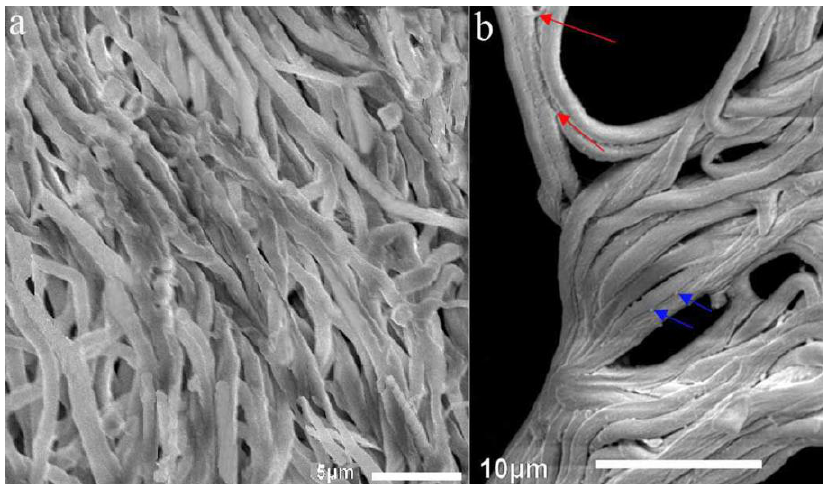
Figure 3. Scanning electron microscopy (SEM) examination of artificial sclerotia at 8 °C and mycelia at 25 °C after 120 days of cultivation. ( a ) depicts loosened mycelia cultured at 25 °C without sclerotial development; ( b ) depicts the condensed and fused mycelia in the SM stage of sclerotial formation cultivated at 8 °C. Images are representatives of three independent experiments. Scale bar, ( a ) 5 µm; ( b ) 10